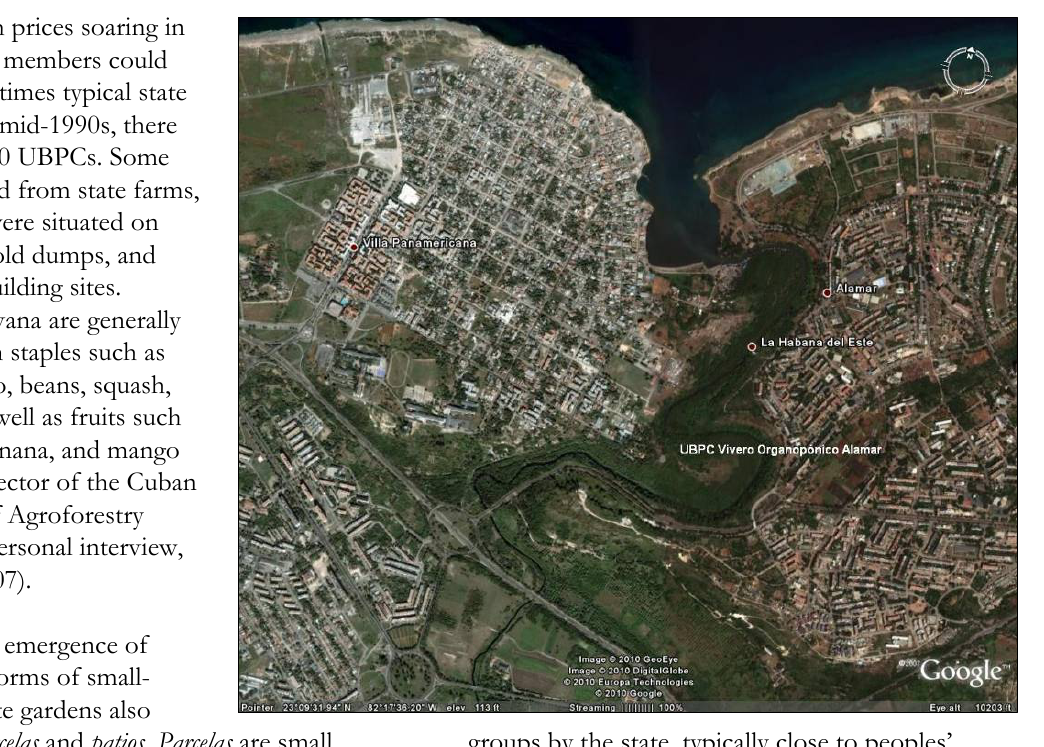
Figure 2. Google Map of Havana Este where one of the UBPCs (Vivero Organopónico Alamar) is